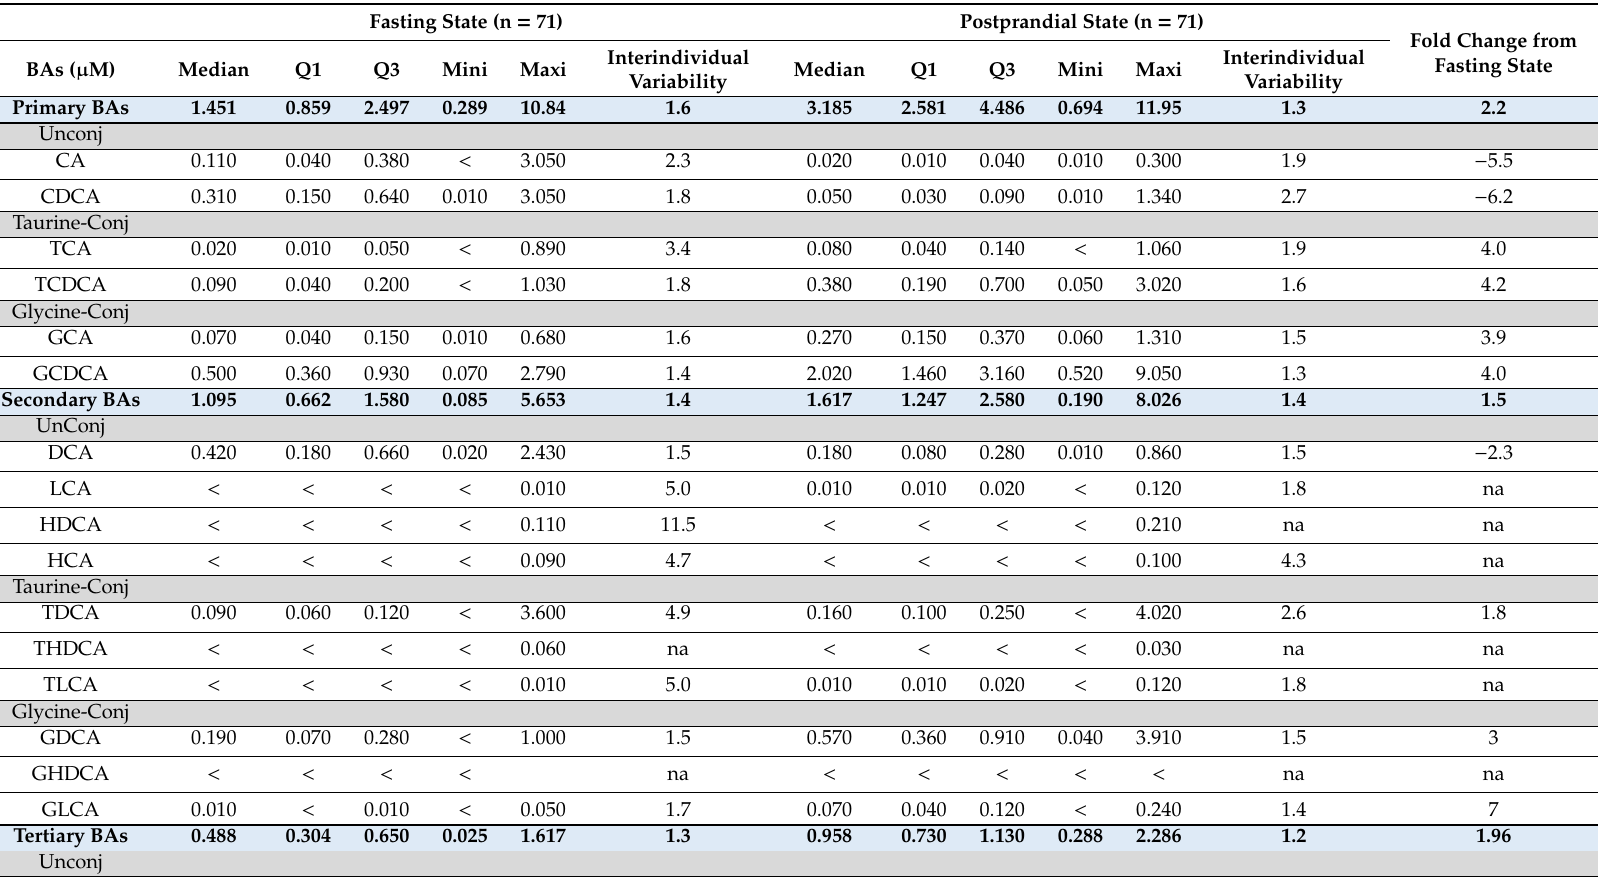
Table 2. Descriptive statistics of circulating bile acids levels in fasting and postprandial